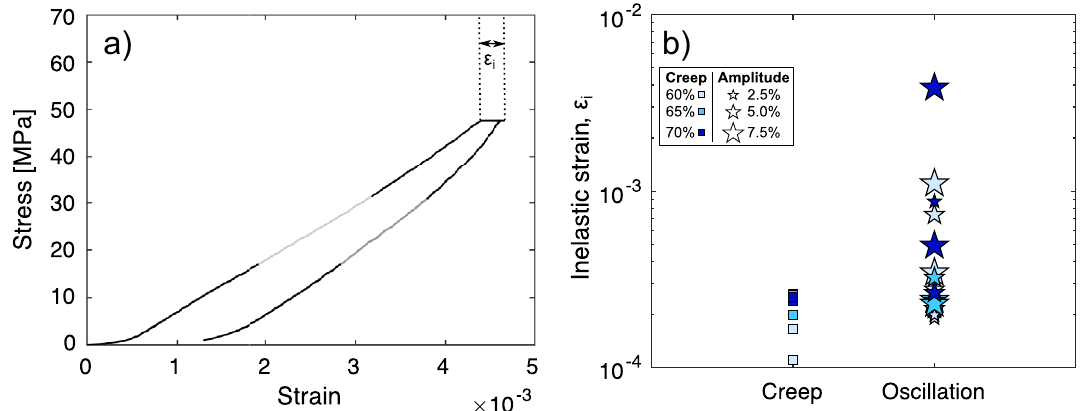
Figure 4. Strain response to mechanical testing. ( a ) Stress–strain curve for a creep test illustrating how the strain (ε i ) at creep is calculated. The light and dark grey sections during the loading and unloading phase respectively show where Young’s modulus (E) was calculated. ( b ) Strain during creep (ε i ; during the load-hold portion) for the different test types (squares are creep tests, stars are oscillation tests). For both creep and oscillation tests the different shades of blue correspond to the different target stresses of the creep portions (the darker the shade, the higher the stress). For oscillation tests, the size of the star depicts the amplitude variation of the stress oscillations with small stars corresponding to ± 2.5%, intermediate to ± 5%, and large to ± 7.5% change from the creep